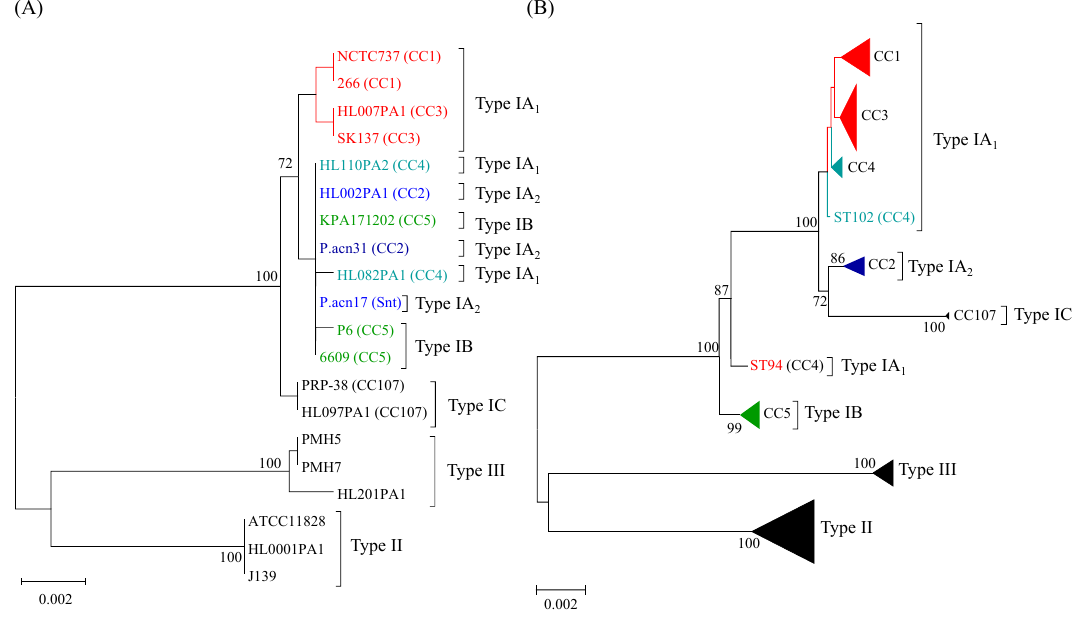
Figure 2. Minimum evolution phylogenetic trees of concatenated recA and tly sequences (1824 bp) from isolates selected to represent all known phylogroups (A), and concatenated gene sequences (4235 bp) from all current STs in the MLST 8 database (B); the latter is updated from [43] with STs. Bootstrapping statistics were performed using 500 data sets, and only bootstrap values ≥ 70% are shown. Clonal complexes (CC) are indicated. An overlapping cluster of strains from CC4 (type IA 1 ), CC2 (type IA 2 ) and CC5 (type IB) can clearly be seen based on analysis of recA and tly sequences (A), but on MLST 8 analysis strains from these different phylogroups form separate, distinct clusters with high bootstrap values (B).